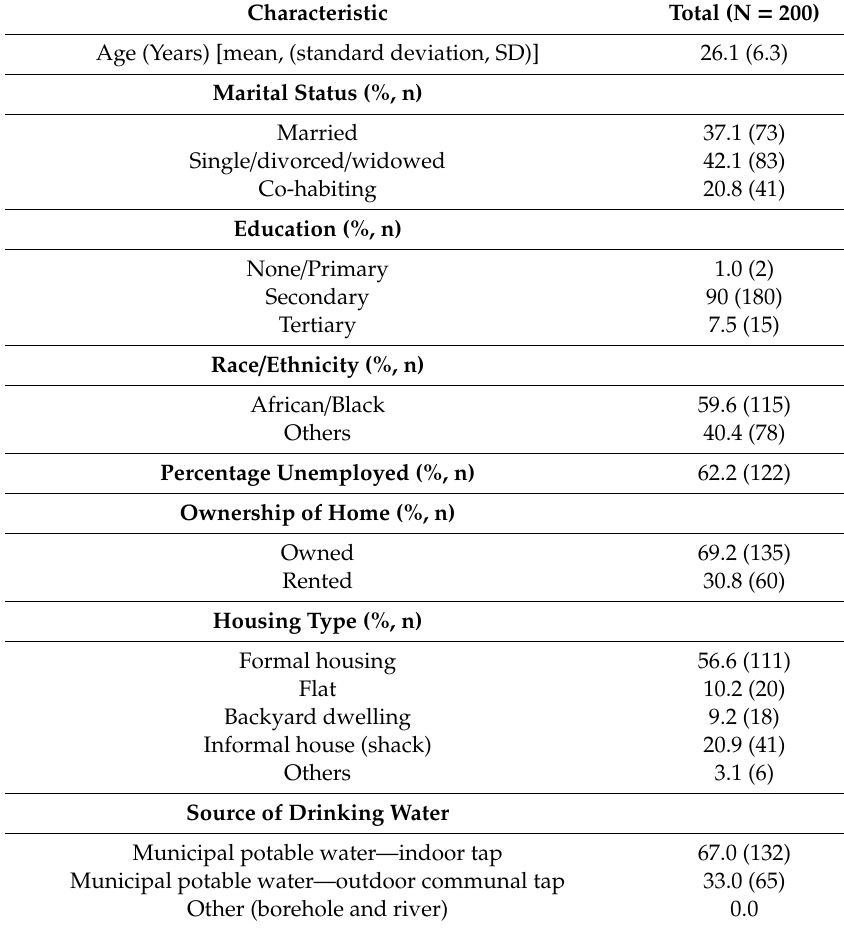
Table 1. Socio-economic and dietary characteristics of